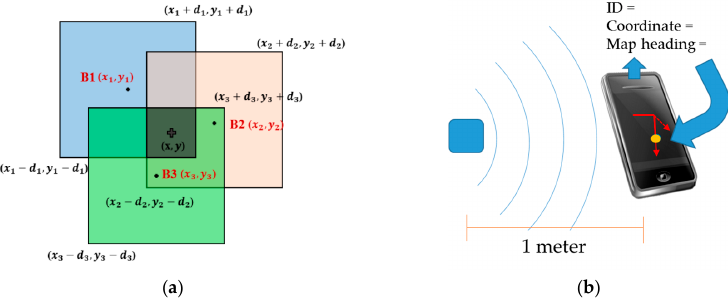
Figure 3. This figure shows the methods used in the proposed system for initialization: ( a ) The bounding box method; ( b ) The proximity